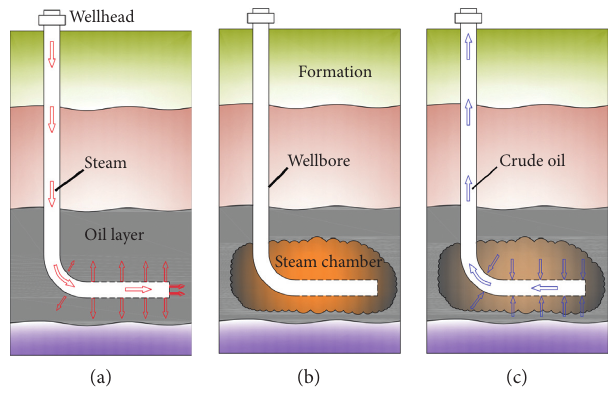
Figure 1: Cyclic steam injection technology. (a) Injection. (b) Soaking. (c)